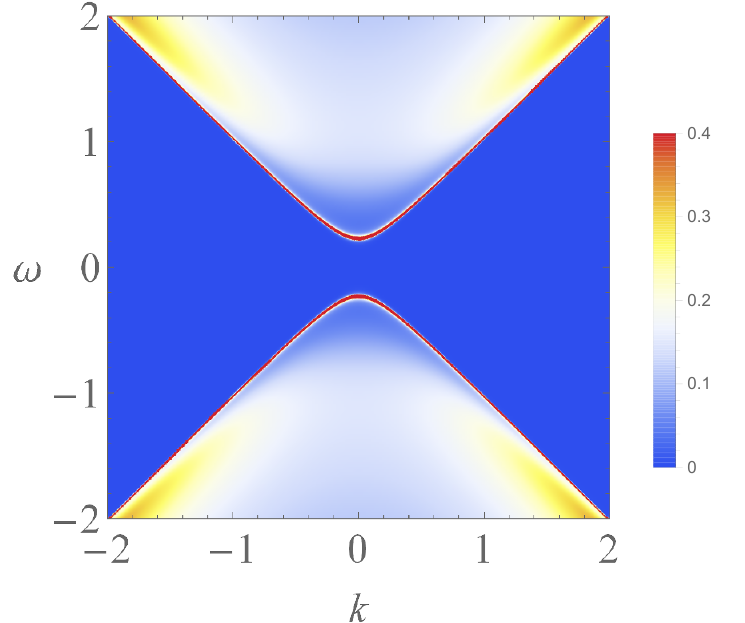
Figure 4 . The undoped spectral function of the elementary fermion for (cid:21) = 1 and g =